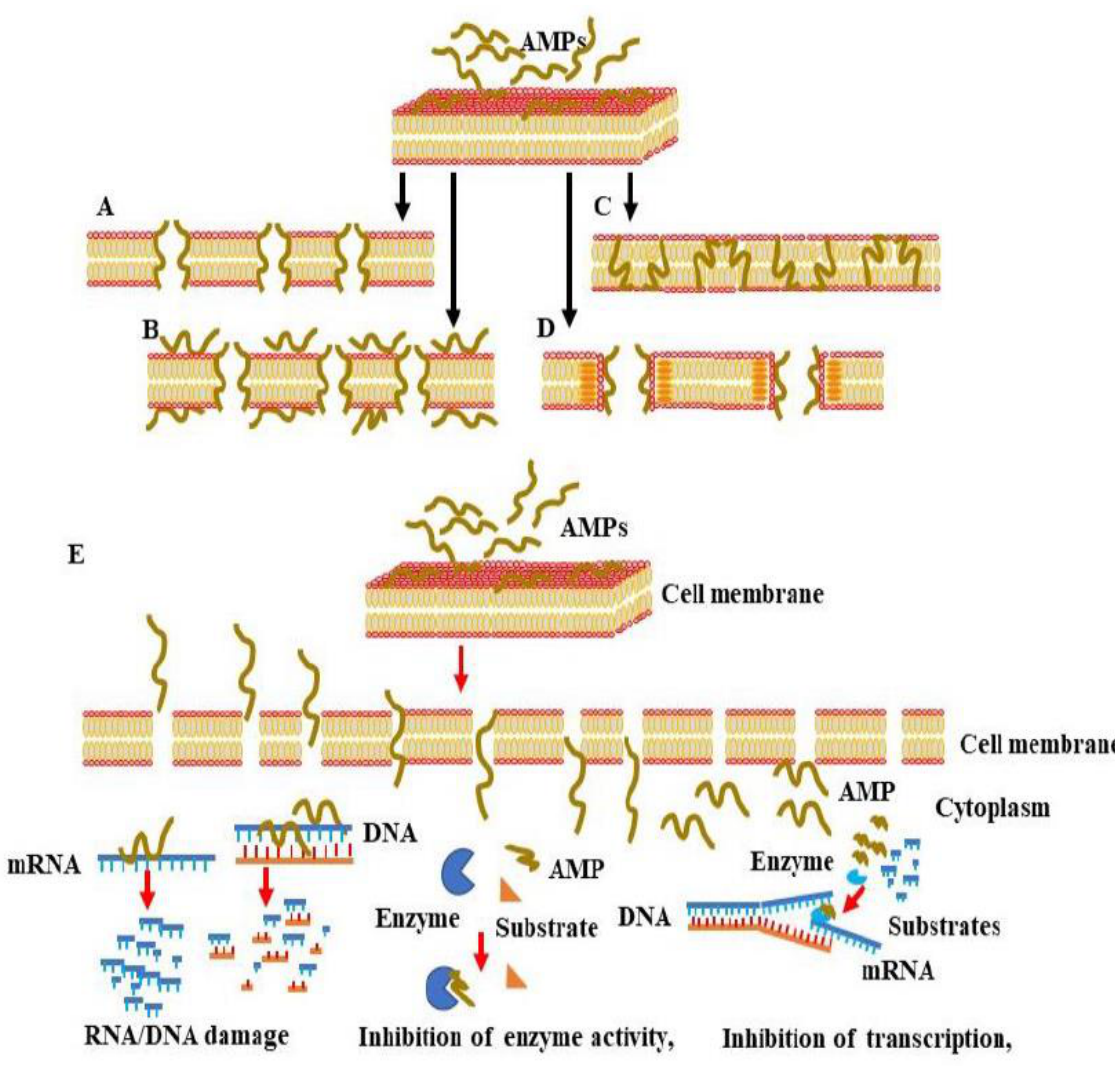
Figure 3. Proposed models for AMP-induced membrane permeability, membrane penetration, and interference with cellular components. AMPs exert their antimicrobial activity via interaction with negatively charged membranes to mediate and rapidly increase membrane permeability, cell membrane lysis, or the release of intracellular contents, leading to microbial cell death. There are four main models of membrane pore formation, namely, the barrel-stave model ( A ), toroidal pore model ( B ), carpet model ( C ) and aggregate model ( D ). ( E ) Mechanisms of the penetration of AMPs into the cytoplasm of the microbial cell and interference with intracellular components.